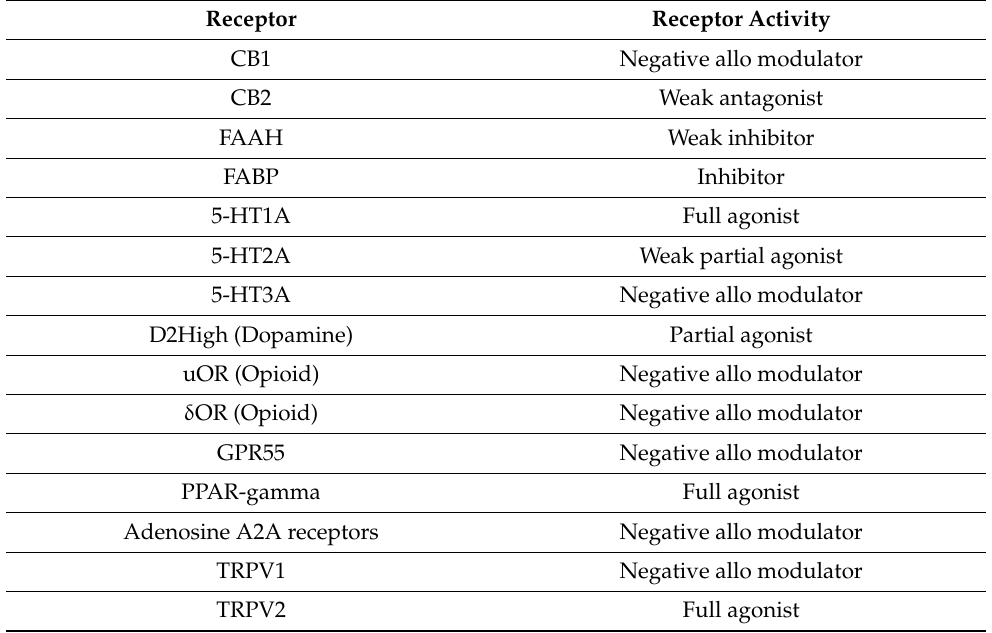
Table 1. Major receptor targets of cannabidiol